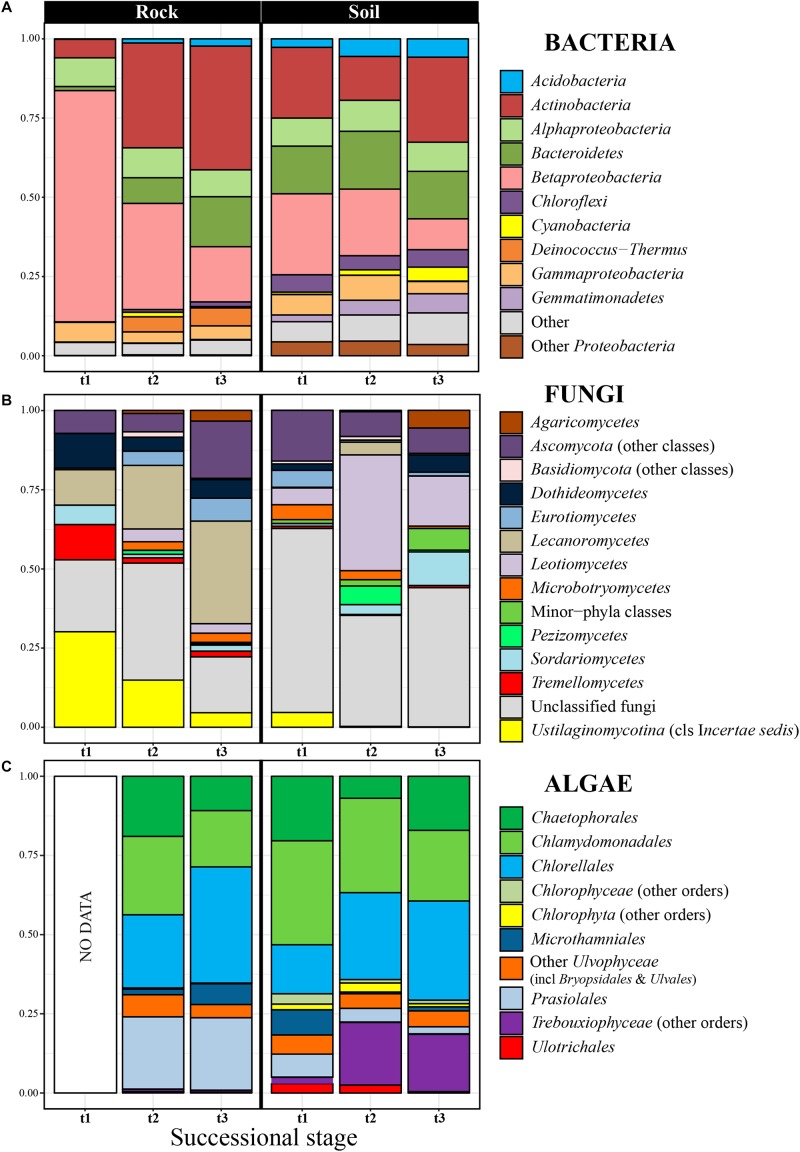
Relative abundance of bacterial phyla (A), fungal classes (B), and algal orders (C) in rocks and soil at the three considered successional stages. Each taxon proportion was calculated as the arithmetic mean of several replicate samples (see Supplementary Figures S3, S7, S8 to check proportions per replicate). The bacterial phylum Proteobacteria was explicitly subdivided into its three most abundant classes in our dataset (Alpha-, Beta- and Gammaproteobacteria).